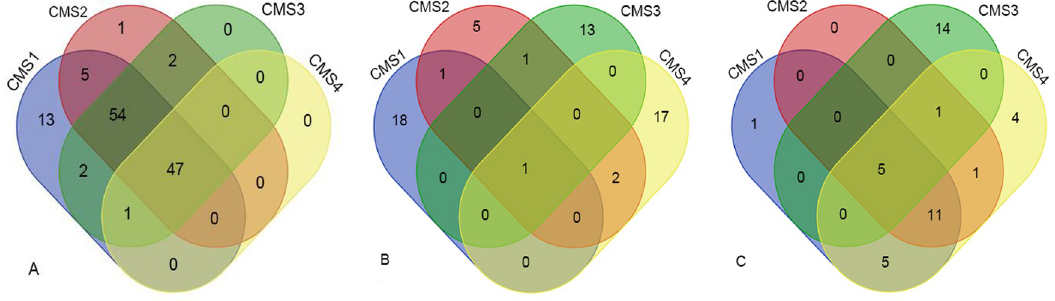
Fig 4. Venn diagram of overlapping results of gene compositions among subtypes. Overlaps of gene organization of three modules from each molecular subtype were shown as NUSAP1(A), CD44(B) and COL4A1(C); a number represented the number of genes shared between/among subtypes or unique to its’